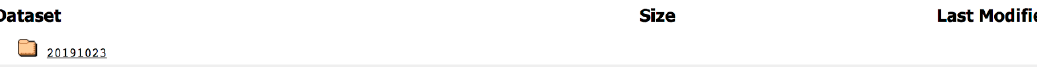
Table 1. Unidata TDS subcatalog big data